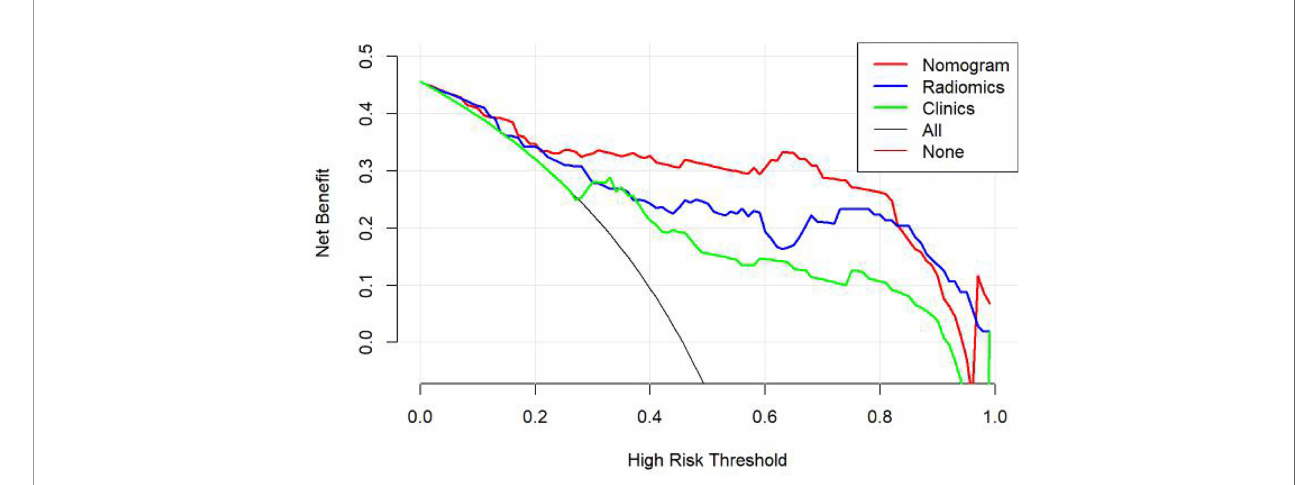
FIGURE 5 | Clinical decision curve of the three models. The green, blue, and red lines correspond to the nomograms from the clinical, radiomic, and nomogram models,